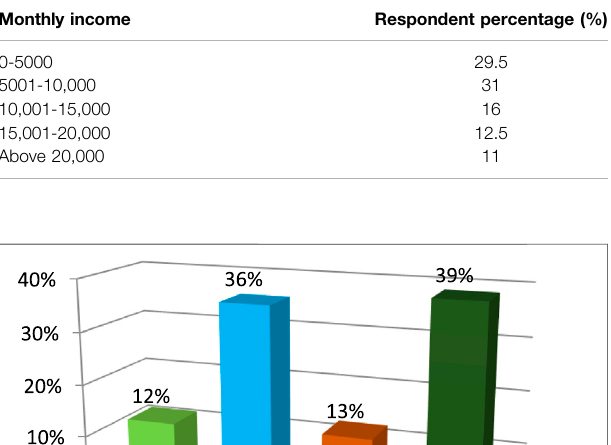
TABLE 6 | Energy use for lighting during load